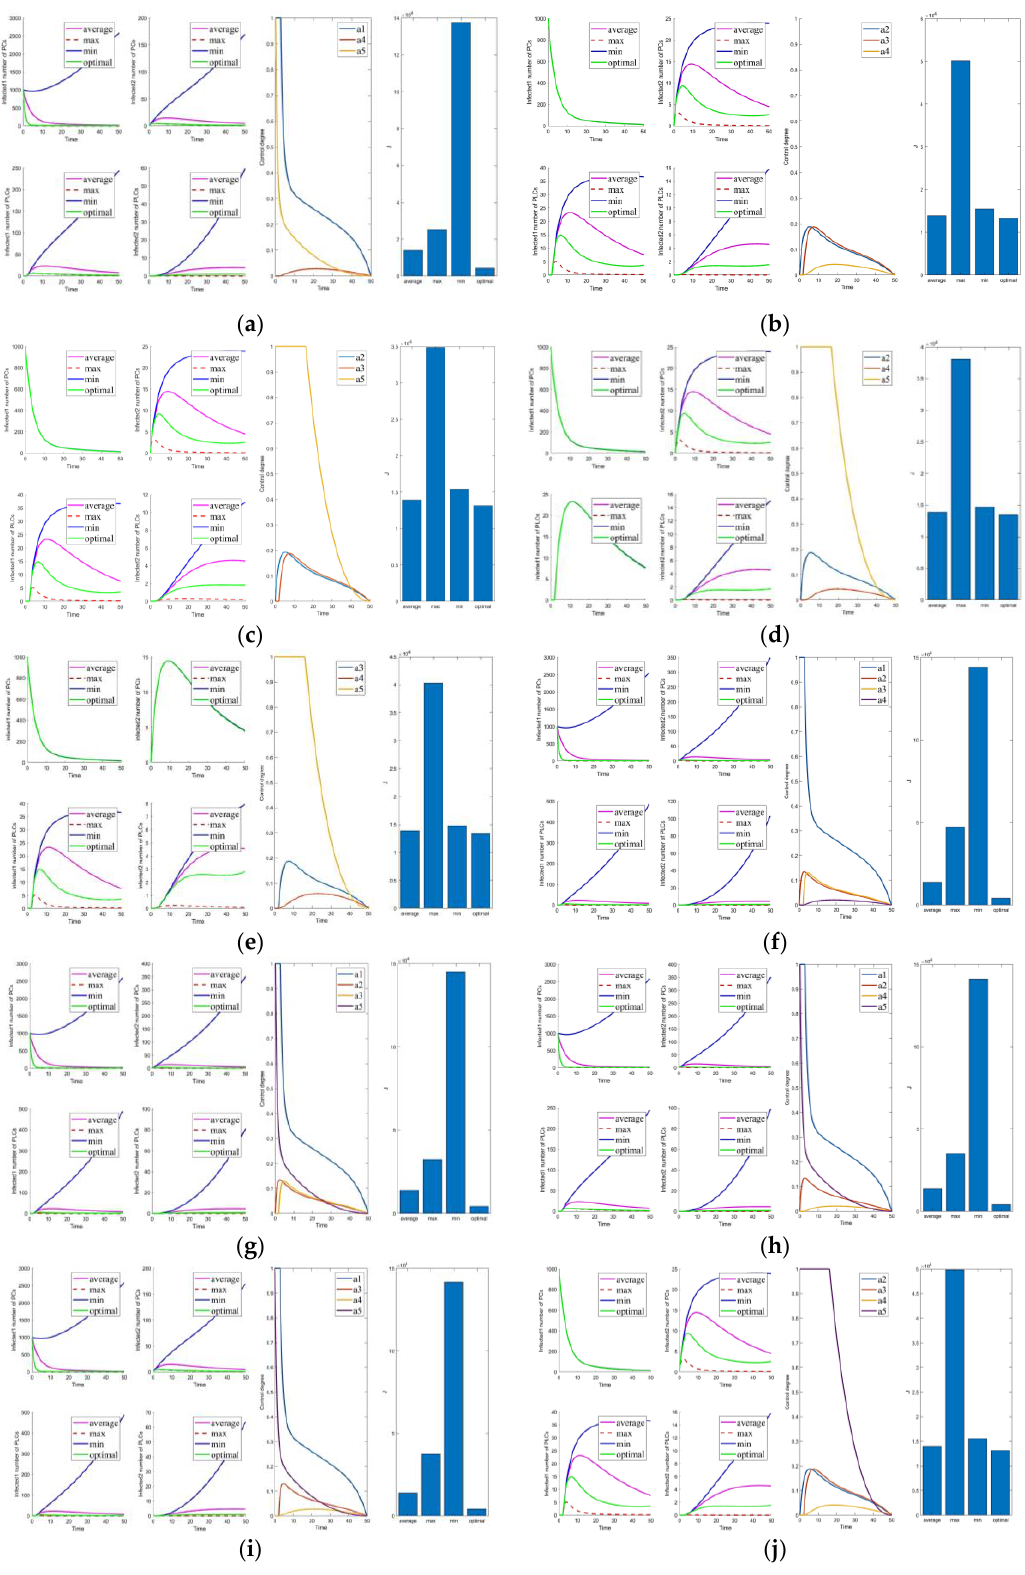
Figure 5. Solutions of the optimal control strategies for Cases 21 – 30. ( a ) Case 21; ( b ) Case 22; ( c ) Case 23; ( d ) Case 24; ( e ) Case 25; ( f ) Case 26; ( g ) Case 27; ( h ) Case 28; ( i ) Case 29; ( j ) Case 30.